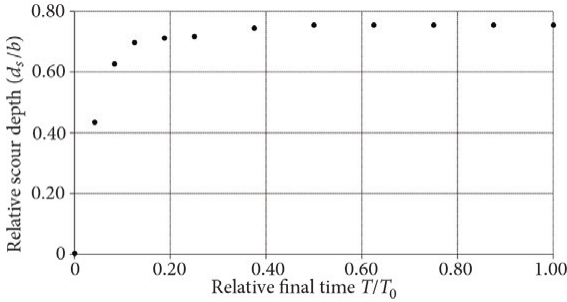
Figure 3. The relative scour depth d s / b against relative final time T / T 0 at F r equal to 0.44 and nose angle at